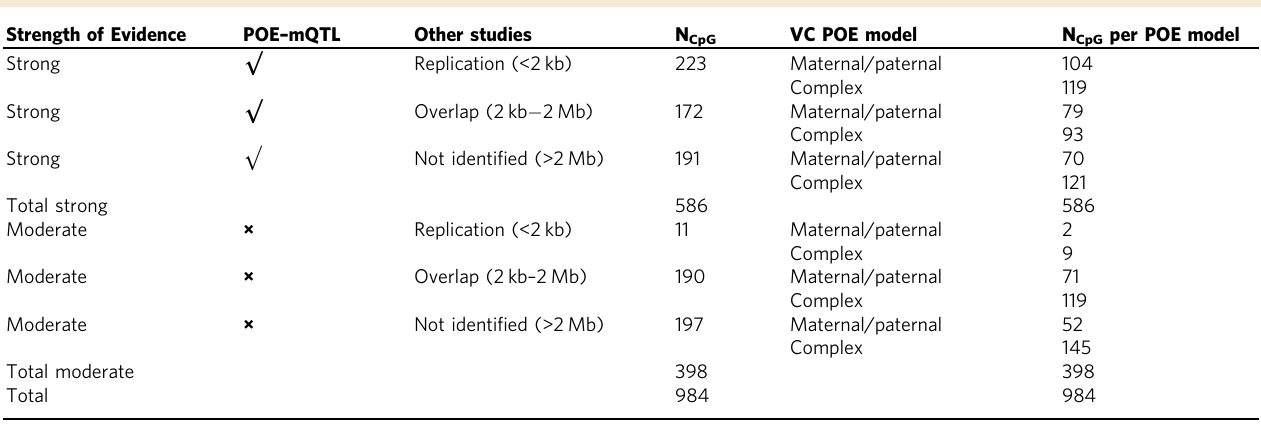
The table classi fi es the 984 candidate CpG sites identi fi ed with the targeted POE variance component (VC) analysis into groups representing the support for the detected POE (strength of evidence) based on having or not an identi fi ed POE – mQTL (POE – mQTL), and if their position overlaps with previously published studies (other studies: replication: the CpG is in a region within 2kb of a known imprinted region; overlap: the CpG is in a region between 2kb and 2Mb of a known imprinted region; not identi fi ed: the CpG is more than 2Mb away from a known imprinted region). N CpGs is the numberof CpGsitesin eachcategory. VCPOEmodelindicates theselectedVC model(maternal/paternalor compleximprinting)and N CpGs perPOEmodelisthe numberof CpGsitesin